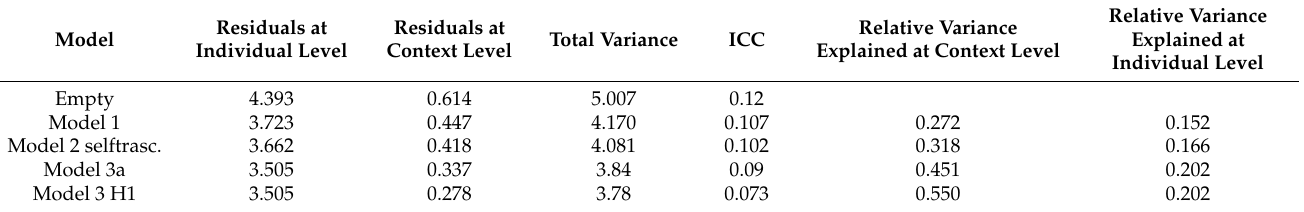
Table 1. Residuals’ inspection and variance explained by the different models at different levels of analysis (a).